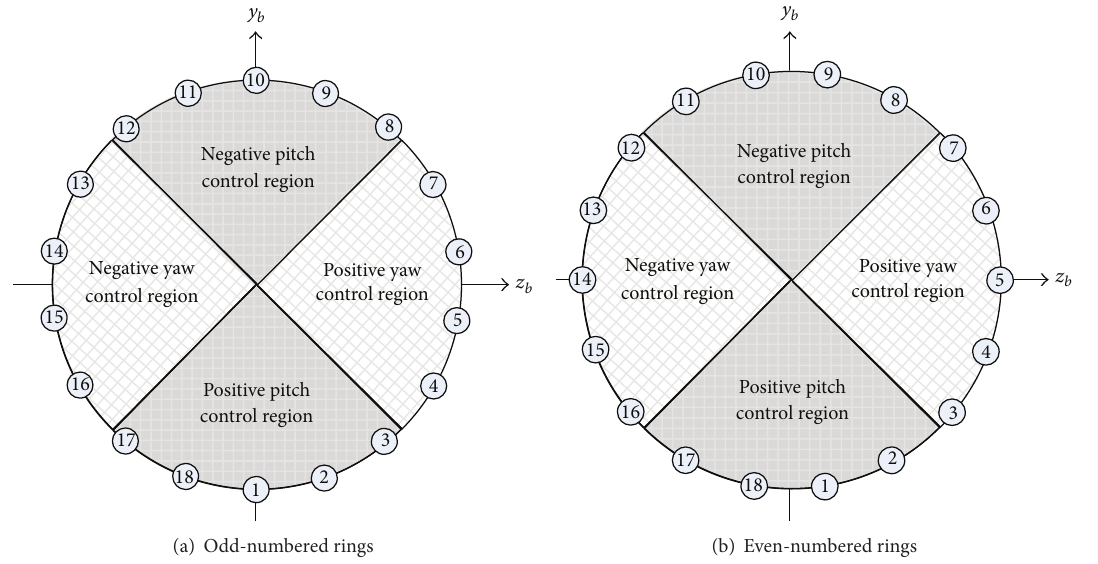
Figure 4: Schematic of control